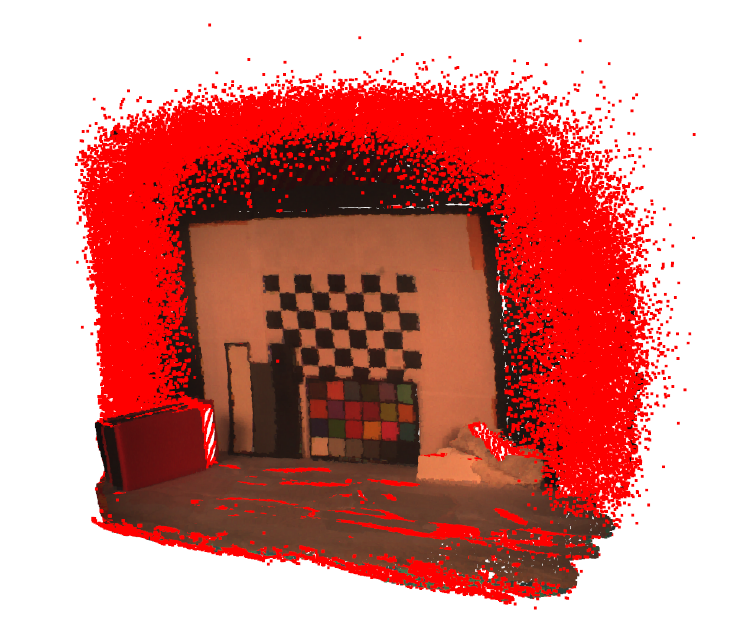
Figure 6. Visualization of the outlier removal for the point cloud in the middle camera viewpoint. The points highlighted with red were